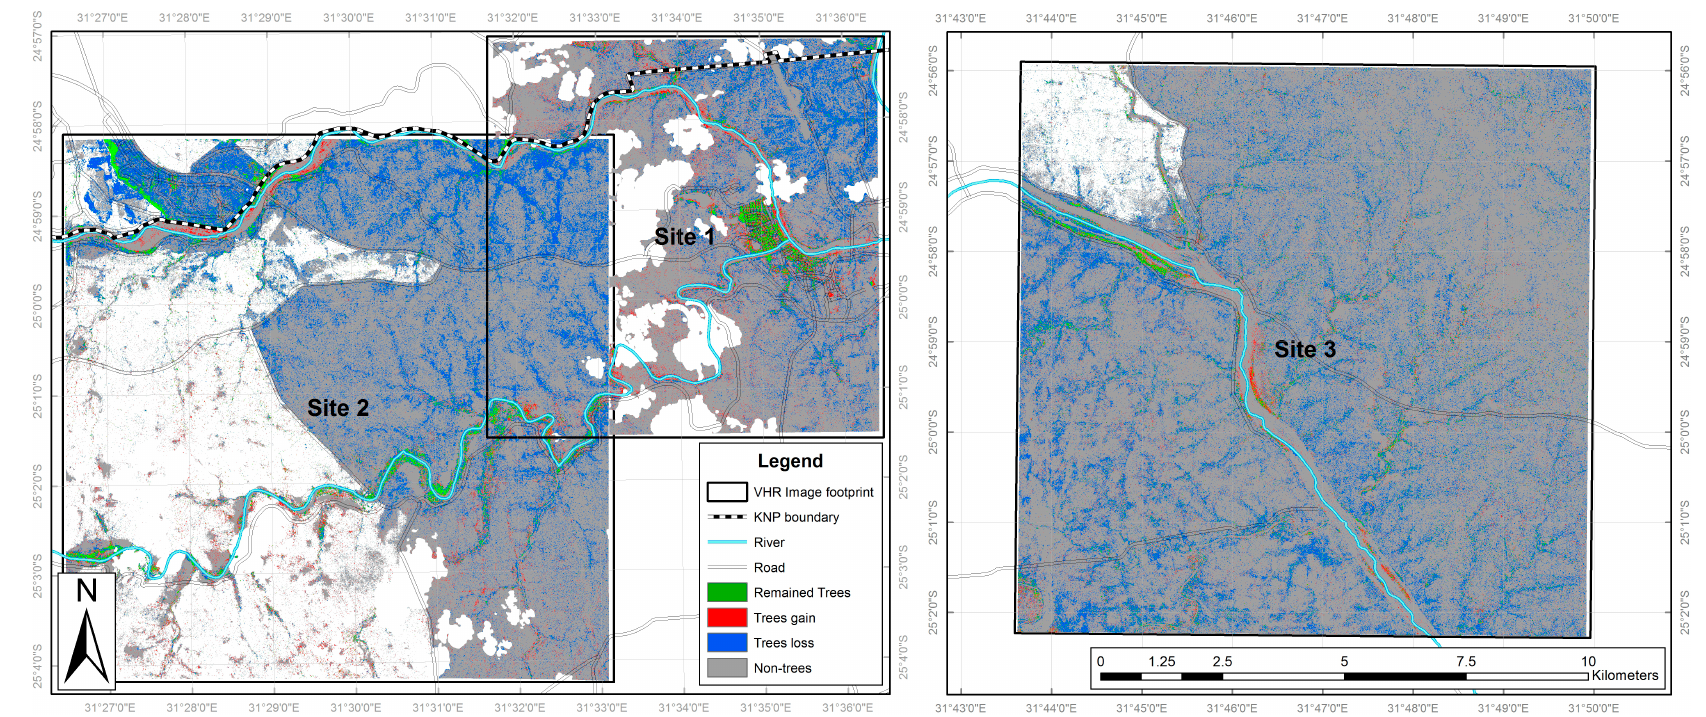
Figure 7. Trees change map illustrating areas of tree increase, decrease, continued presence and absence.